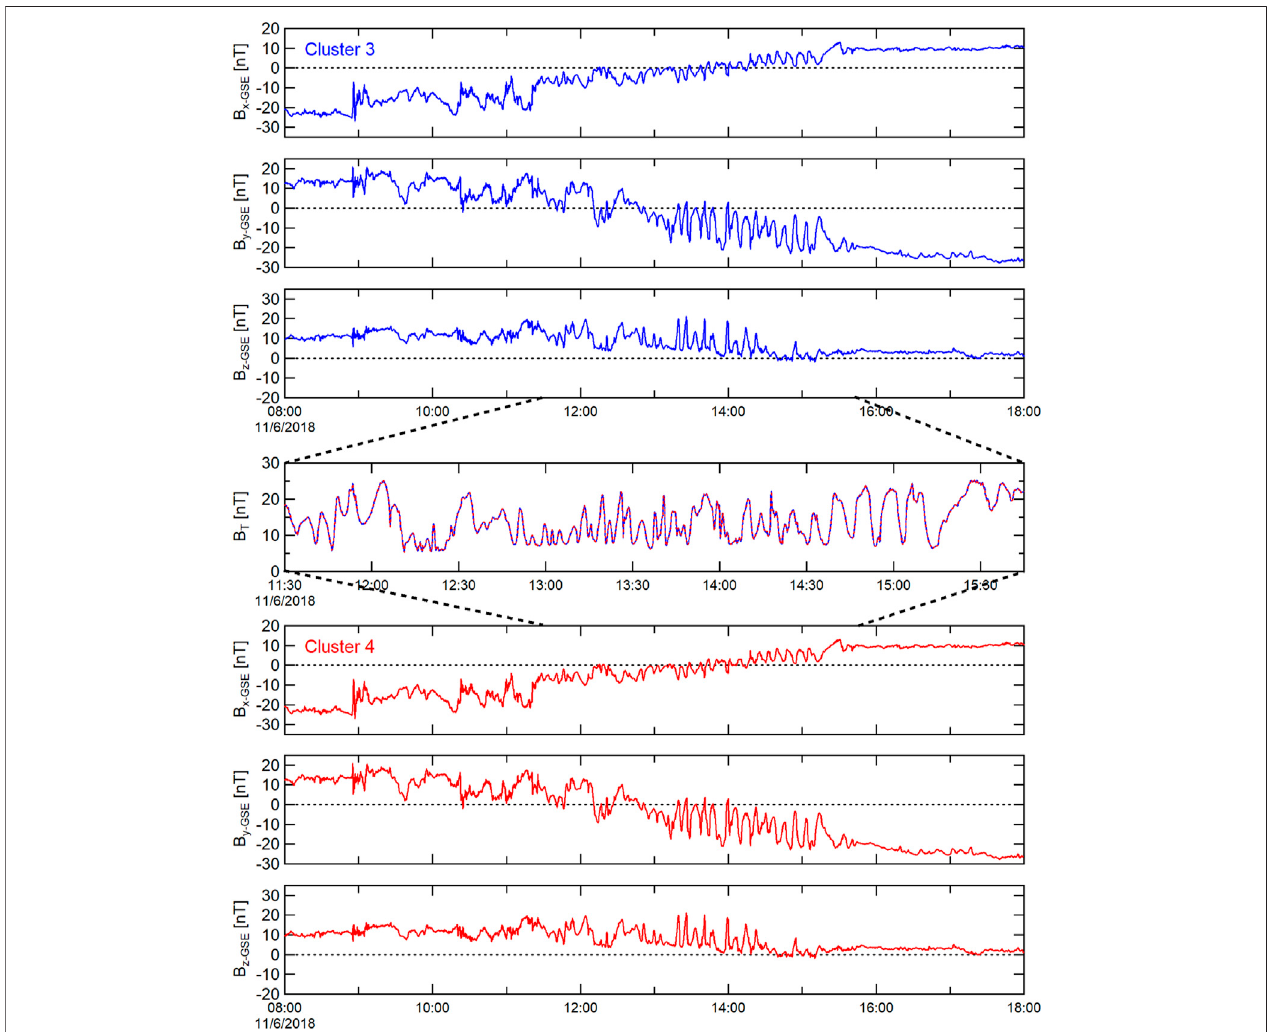
FIGURE 6 | Magnetic fi eld observations from Cluster 3 and Cluster 4, in GSE coordinates. These spacecraft were initially in the southern lobe (strong and rather steady negative B x ), and ended in the northern magnetotail lobe (strong and rather steady positive B x ). During the time spent near the magnetopause and fl ank neutral sheet, coherent transverse and compressional waves were observed in the magnetic fi eld. Magnetic fi eld intensity (and compressional waves) from the two spacecraft are overlaid in the fourth (middle) panel, and are essentially identical in amplitude, frequency, and phase. Highest frequency waves are closest to the neutral sheet (B x near